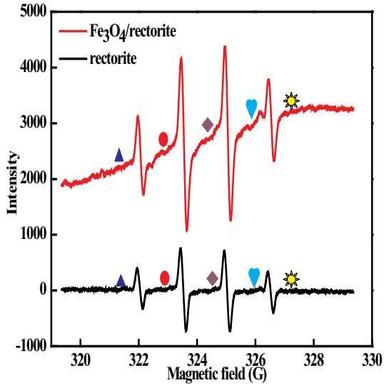
ESR spectra for the DMPO-∙OH of the rectorite and Fe3O4/rectorite catalytic system with H2O2.